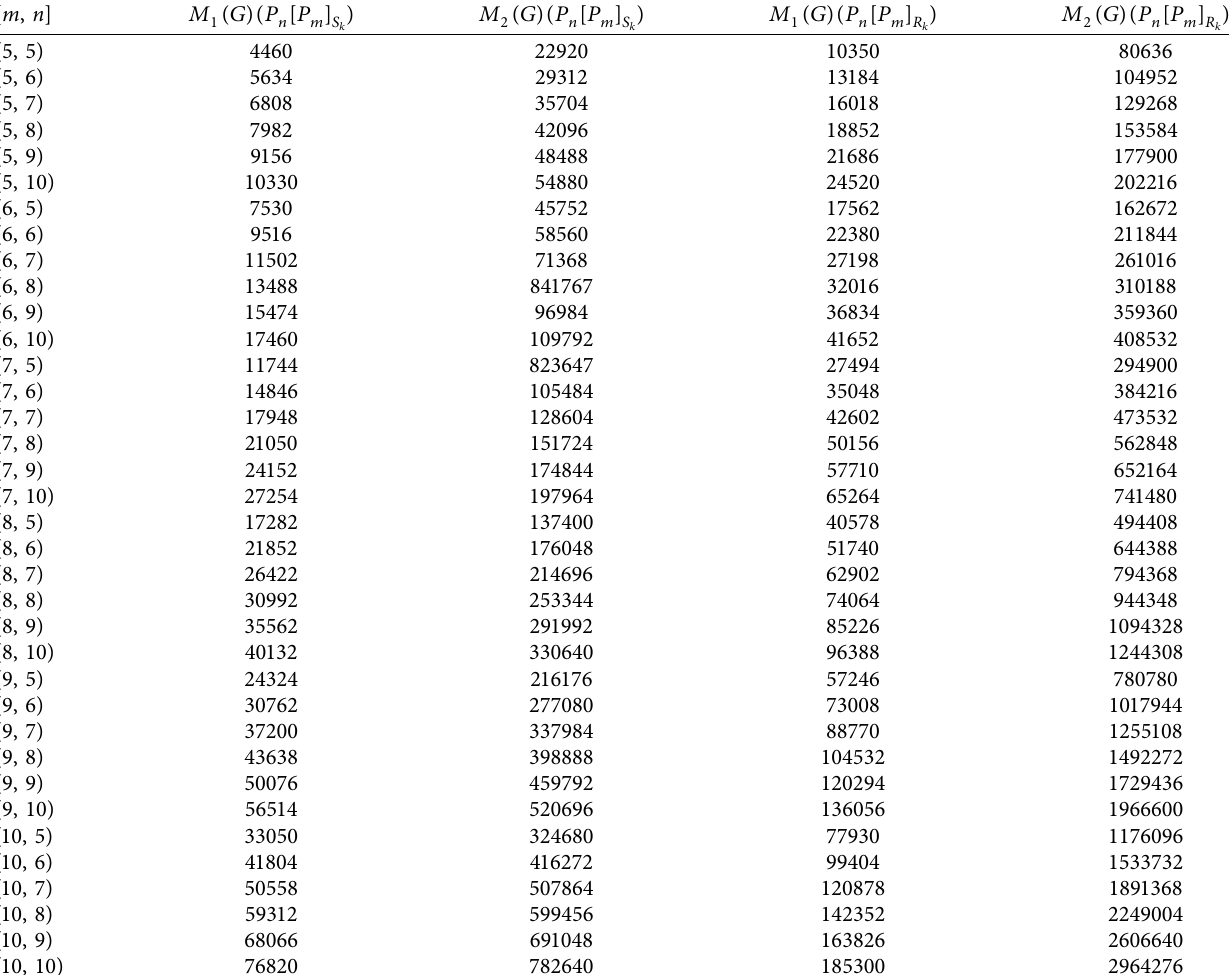
[ P ] ) for k � 1. n m T k